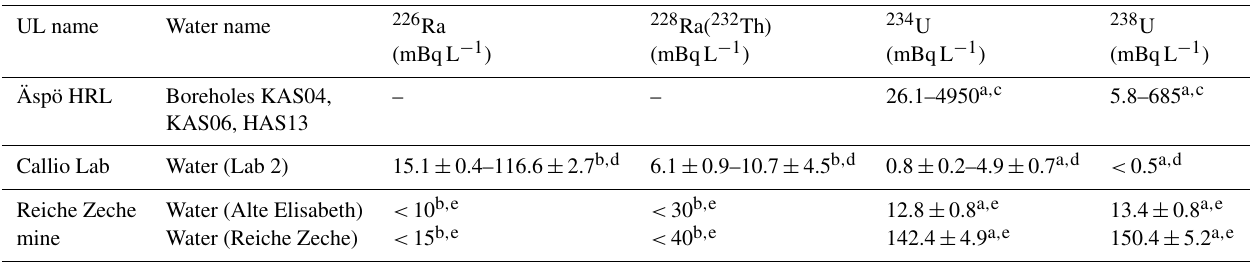
Table 5. Results of radioisotope concentrations in water samples in BSUIN and EUL ULs.